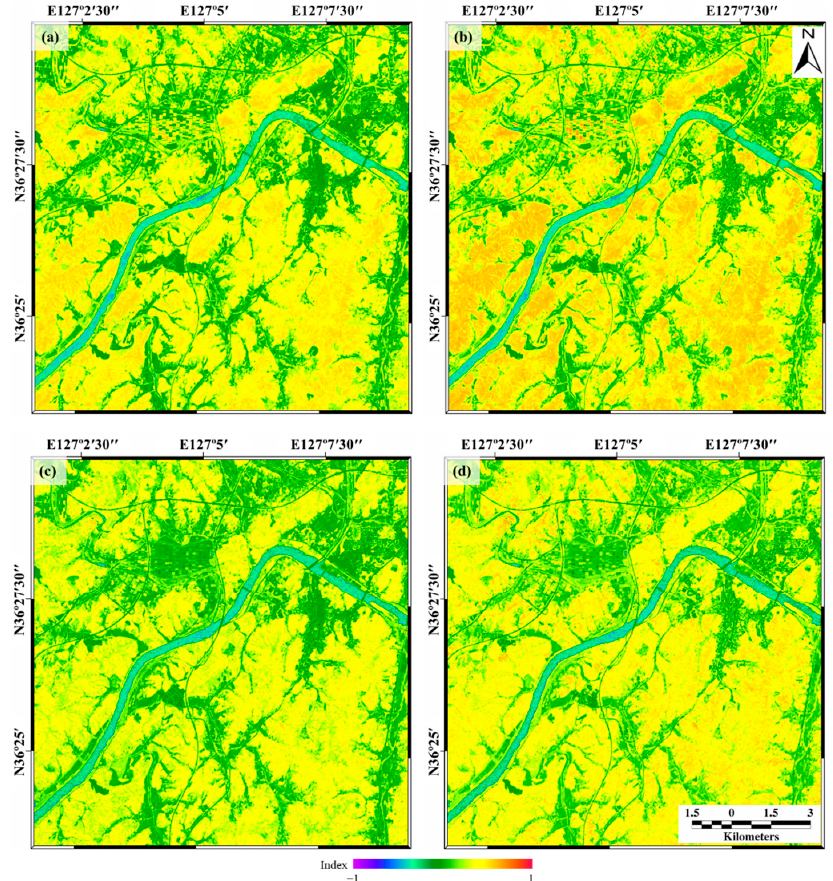
Figure 8. Input neurons of NDre1 and NDre2 created from Sentinel-2 image: ( a ) NDre1 images in spring and ( b ) fall season, ( c ) NDre2 images in spring and ( d ) fall season. In addition, PCA texture maps were generated using Equations (4) and (5) from seasonal Sentinel-2 optic satellite images, respectively. The smoother the surface, the higher the texture values as shown in Figure 9a,b.